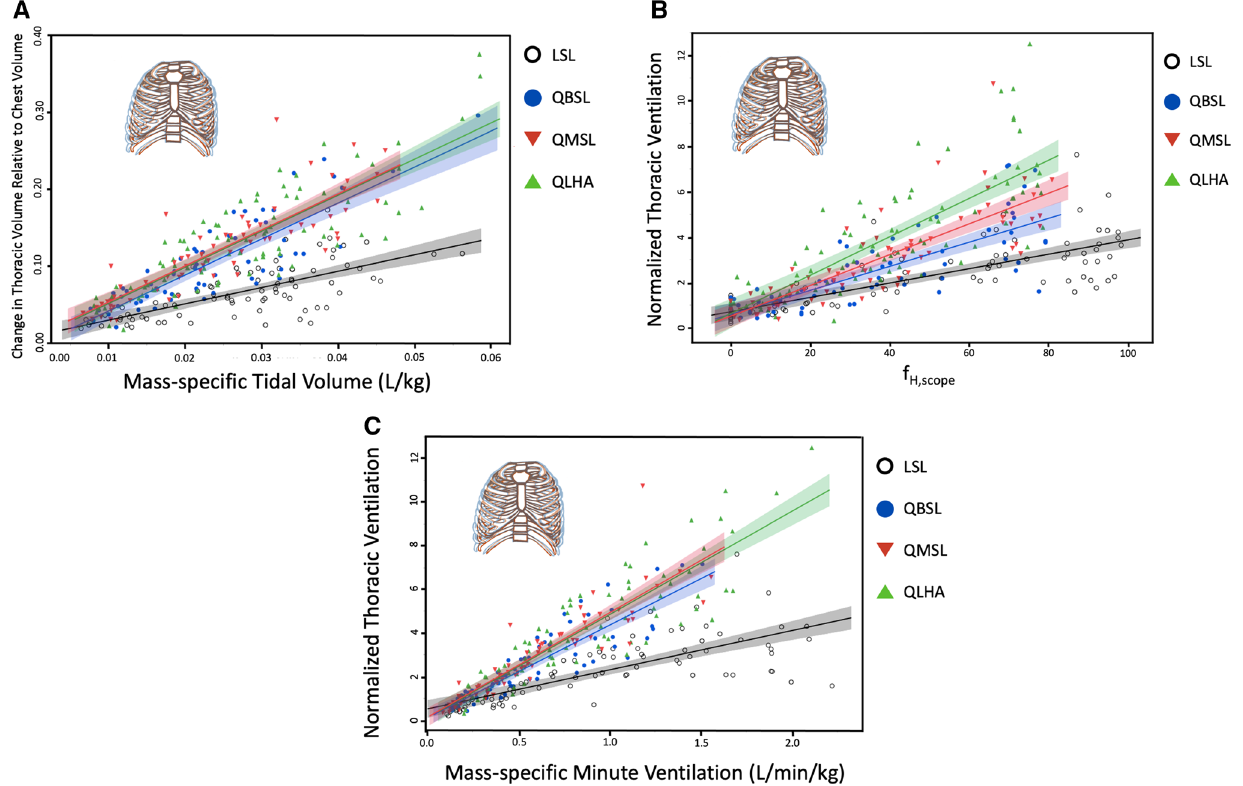
Figure 4. ( A ) Thoracic expansion and contraction relative to chest volume increased with mass-specific V T (L/ kg) in QLHA (slope ± S. 4.49 ± 0.23, R 2 = 0.47), QMSL (4.84 ± 0.24, R 2 = 0.66), QBSL (4.51 ± 0.24, R 2 = 0.50), and LSL (2.27 ± 0.17, R 2 = 0.36) participants. Shading represents 95% CIs. ( B ) Normalized thoracic ventilation, or the amount air inhaled per minute using the chest normalized to average chest volume, increases with f H,scope ˙ V in all populations. ( C ) Normalized thoracic ventilation increases with mass-specific E (L/min/kg-BTPS) in QLHA (slope ± S. 4.74 ± 0.19, R 2 = 0.80), QMSL (4.94 ± 0.23, R 2 = 0.78), QBSL (4.18 ± 0.22, R 2 = 0.78) and LSL (2.26 ± 0.15, R 2 = 0.55) participants. Shading represents 95% CIs. Multiple measures from individual participants are presented together for graphical clarity. Repeated measures in participants are accounted for and fixed effects assessed via non-linear mixed effects models using generalized least squares (see “Statistical